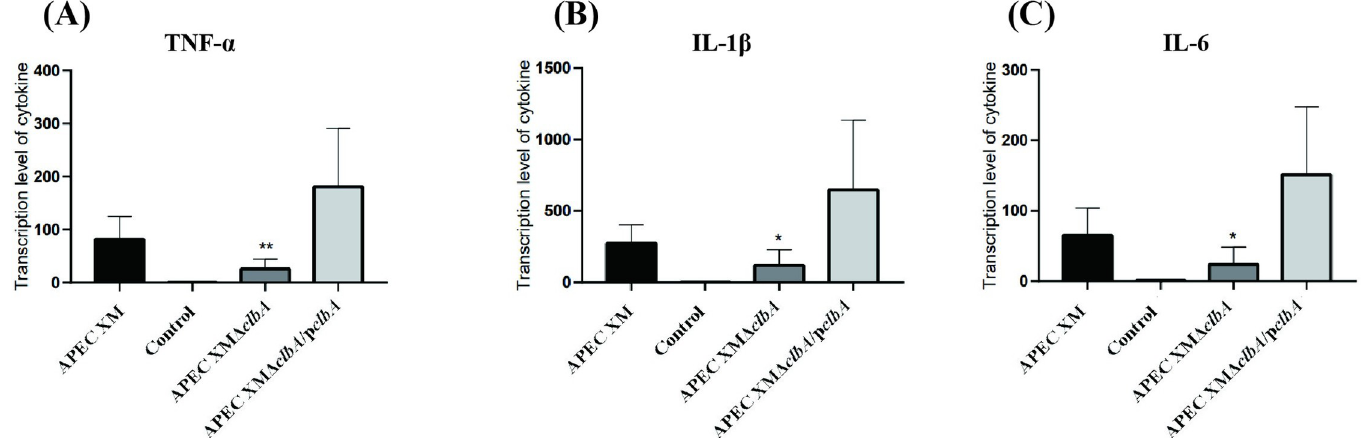
Fig 9. The mRNA transcript levels of inflammatory cytokines TNF- α (A), IL-1 β (B), and IL-6 (C) were determined by qRT-PCR. This experiment was repeated three times. 3 mice were used in each group for each experiment. The relative gene expression level was calculated using the 2 - 44 CT method. GAPDH was used as the normalizing internal standard. The data were analyzed with SPSS 17.0 software using one-way ANOVA and presented as mean ± standard deviations of three replicates. Significant differences between APEC XM Δ clbA and APEC XM are indicated ( �� , p < 0.01, � , 0.01 < p < 0.05, versus APEC XM group).